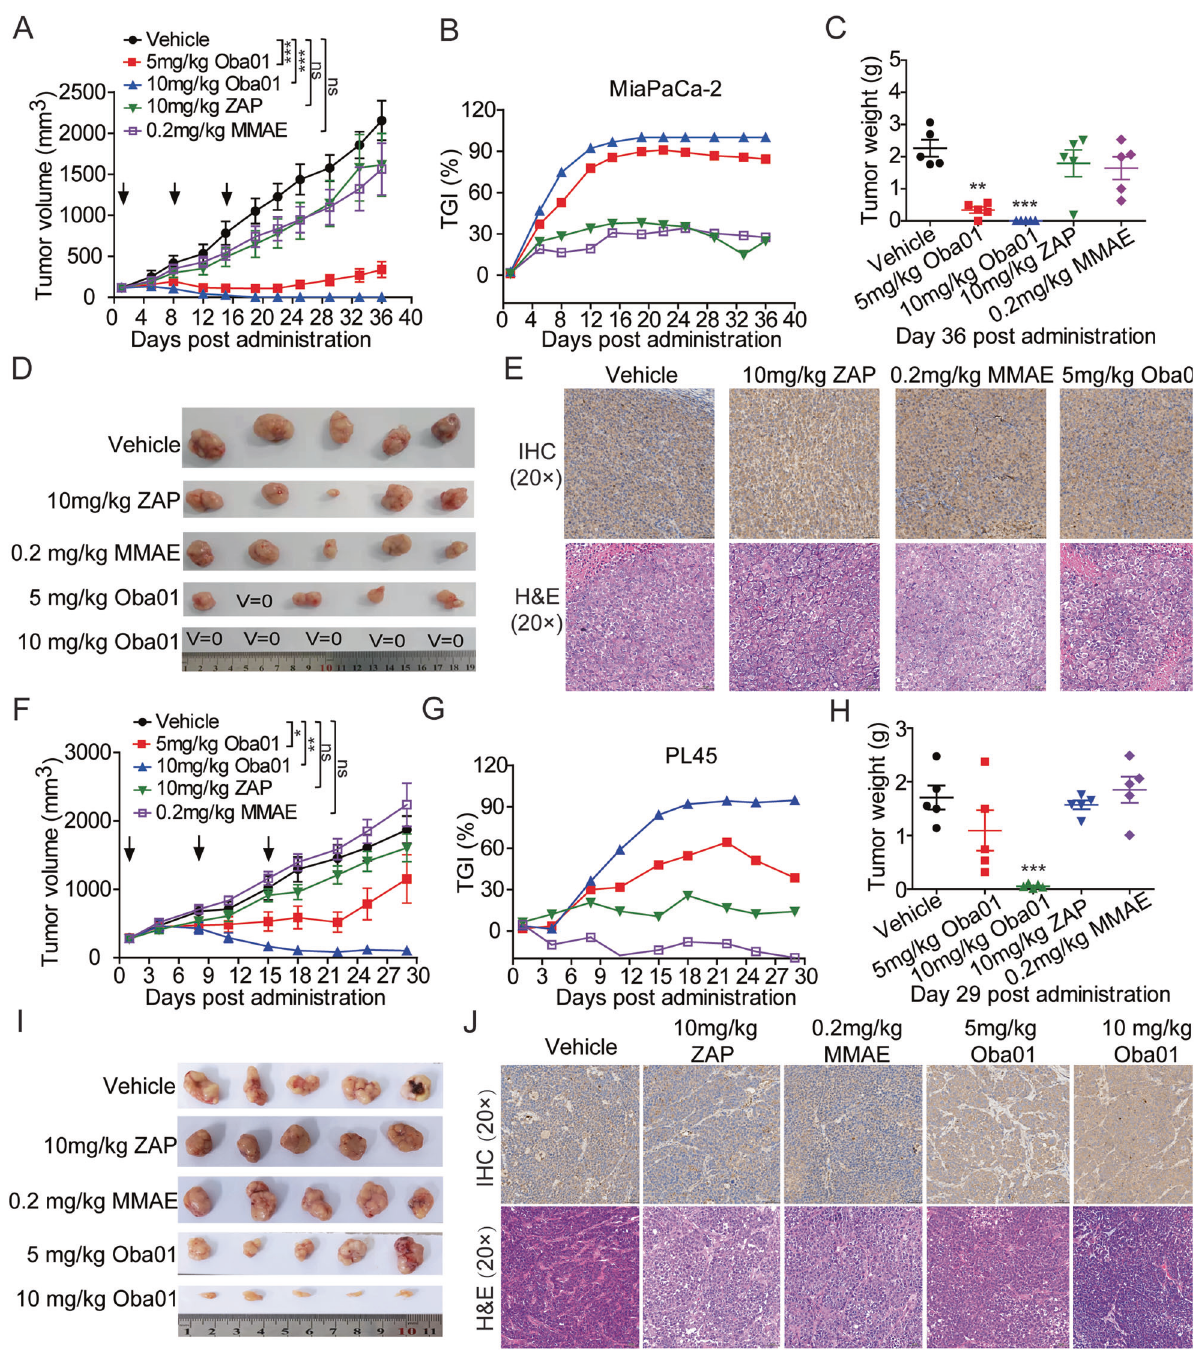
Fig. 4 Antitumor activity of Oba01 in mouse CDX models. A , B Tumor growth curve and inhibition rate of tumor growth (TGI) in a Mia PaCa- 2 CDX model. C , D Transplanted tumor weights and tumor images were evaluated at the end of the experiment in the Mia PaCa-2 CDX model. E IHC analysis of DR5 expression (upper panels) and H&E staining (lower panels) in the transplanted tumors derived from the mice shown in panel 4D. F , G Tumor growth curve and TGI in the PL45 CDX model. H , I Transplanted tumor weights and tumor images assessed at the end of the experiment in the PL45 CDX model. J IHC analysis of DR5 expression (upper panels) and H&E staining (lower panels) in the transplanted tumors derived from the mice shown in panel 4I. IHC and H&E Images were captured at 200×magni fi cation, respectively. Scale bars = 50